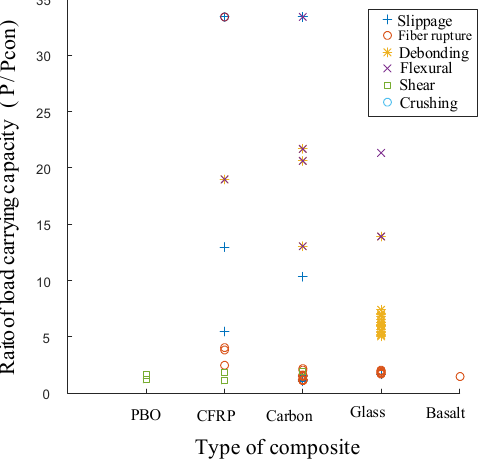
Figure 21. An increase in load-carrying capacity ratio vs. composite type with respect to FMs.